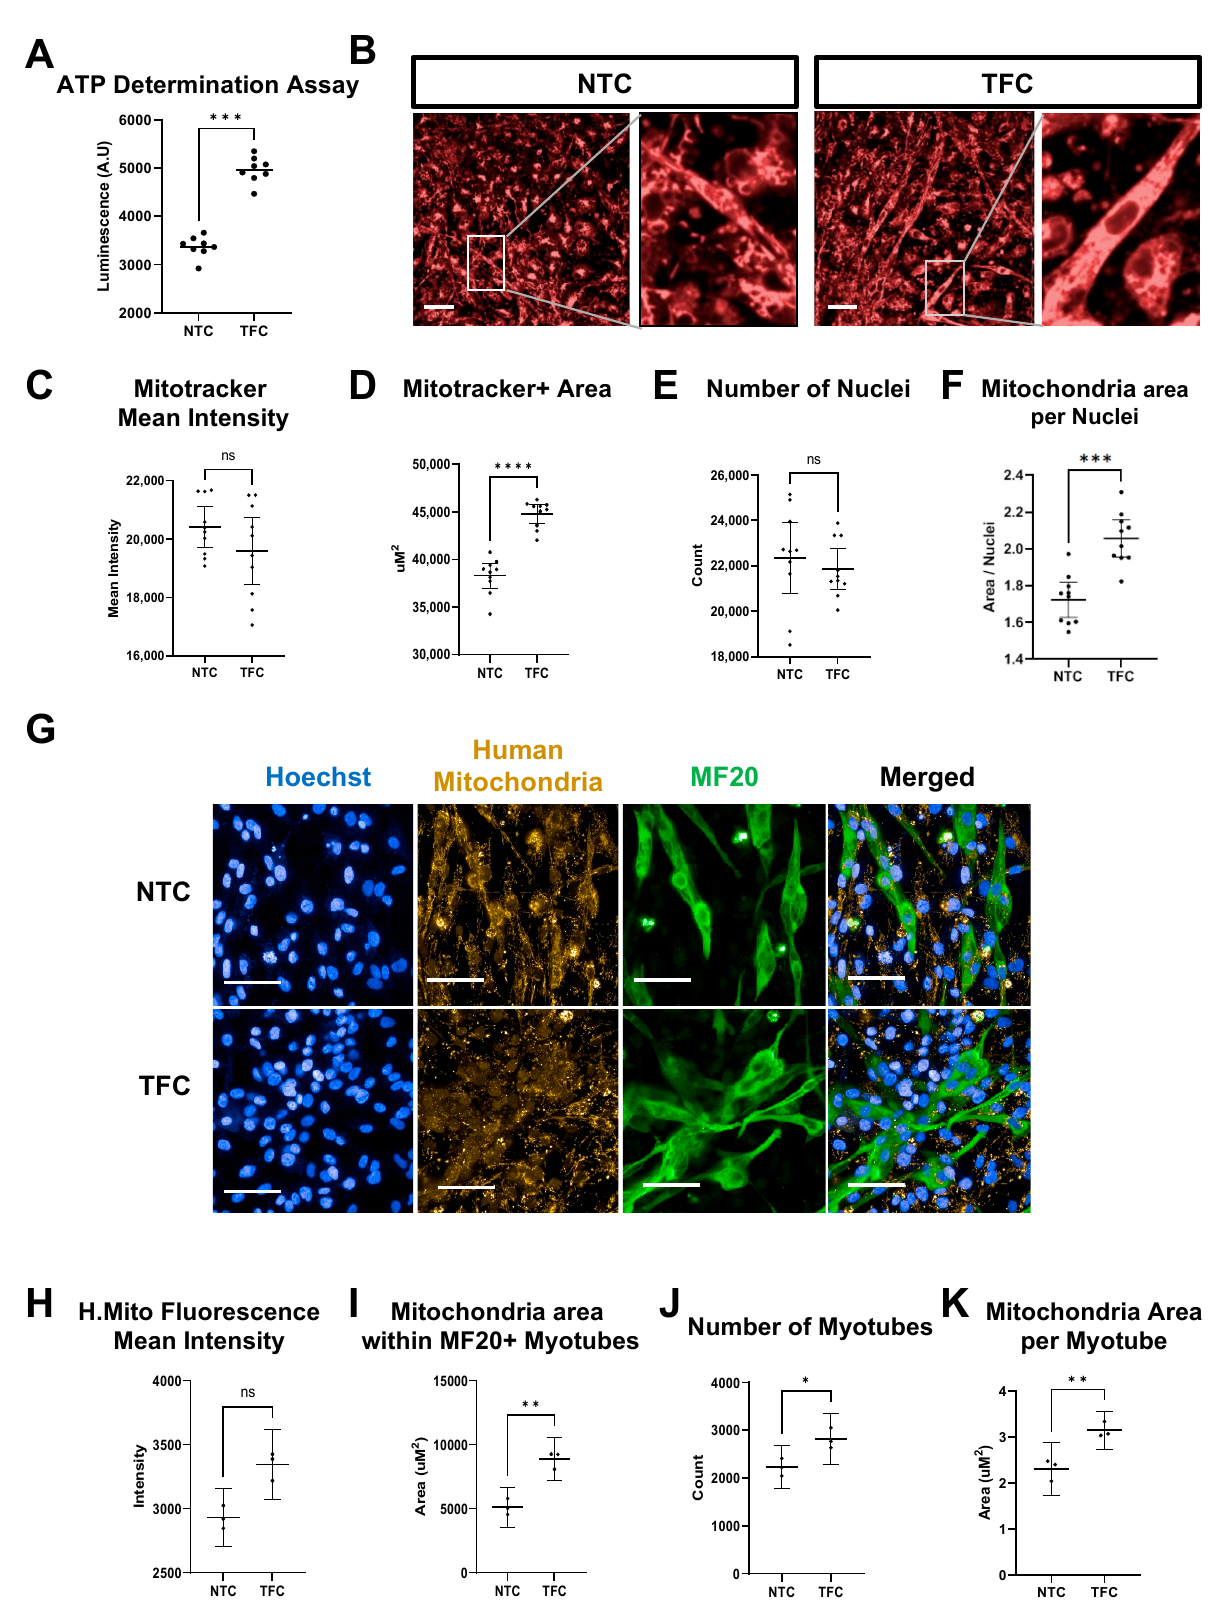
Figure 5. TFC treatment enhanced oxidative phosphorylation in hESC-SkMC. ( A ) Quantitative deter- mination of ATP between NTC and TFC-treated hESC-SkMC. N = 8 for each condition. ( B )